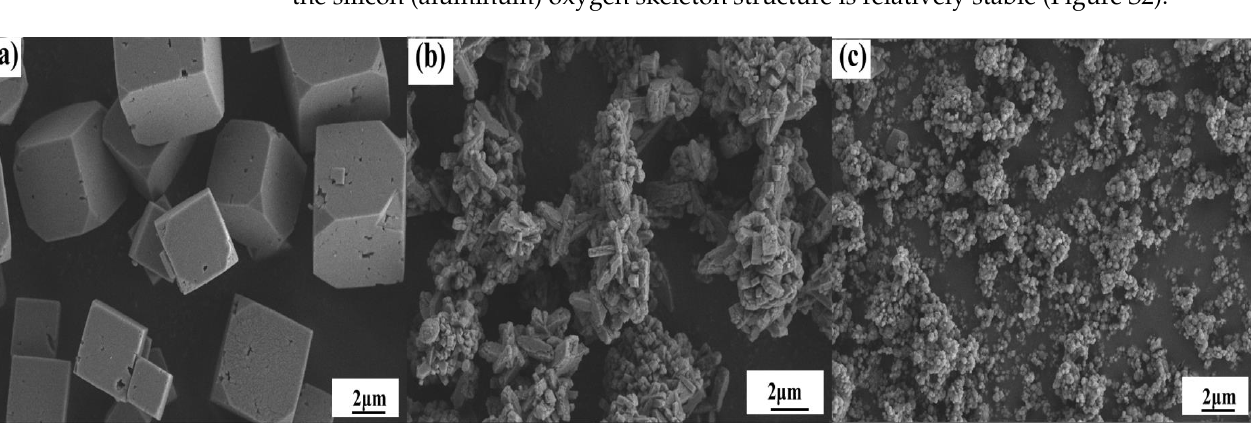
Figure 4. SEM images of Cu-SSZ-13 ( a ), Cu-ZSM-5 ( b ) and Cu-Beta ( c ).